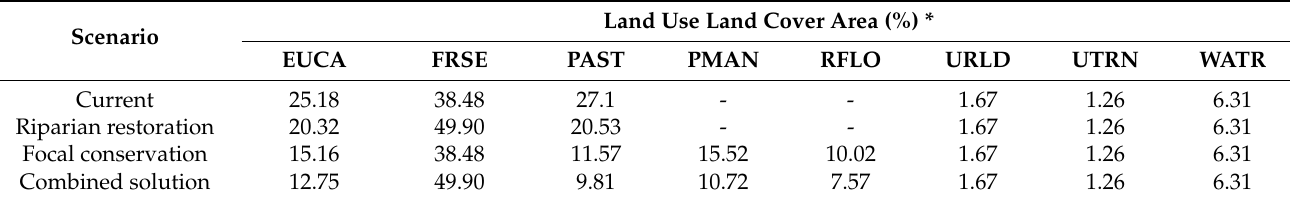
Table 3. Land use and cover area for each LULC